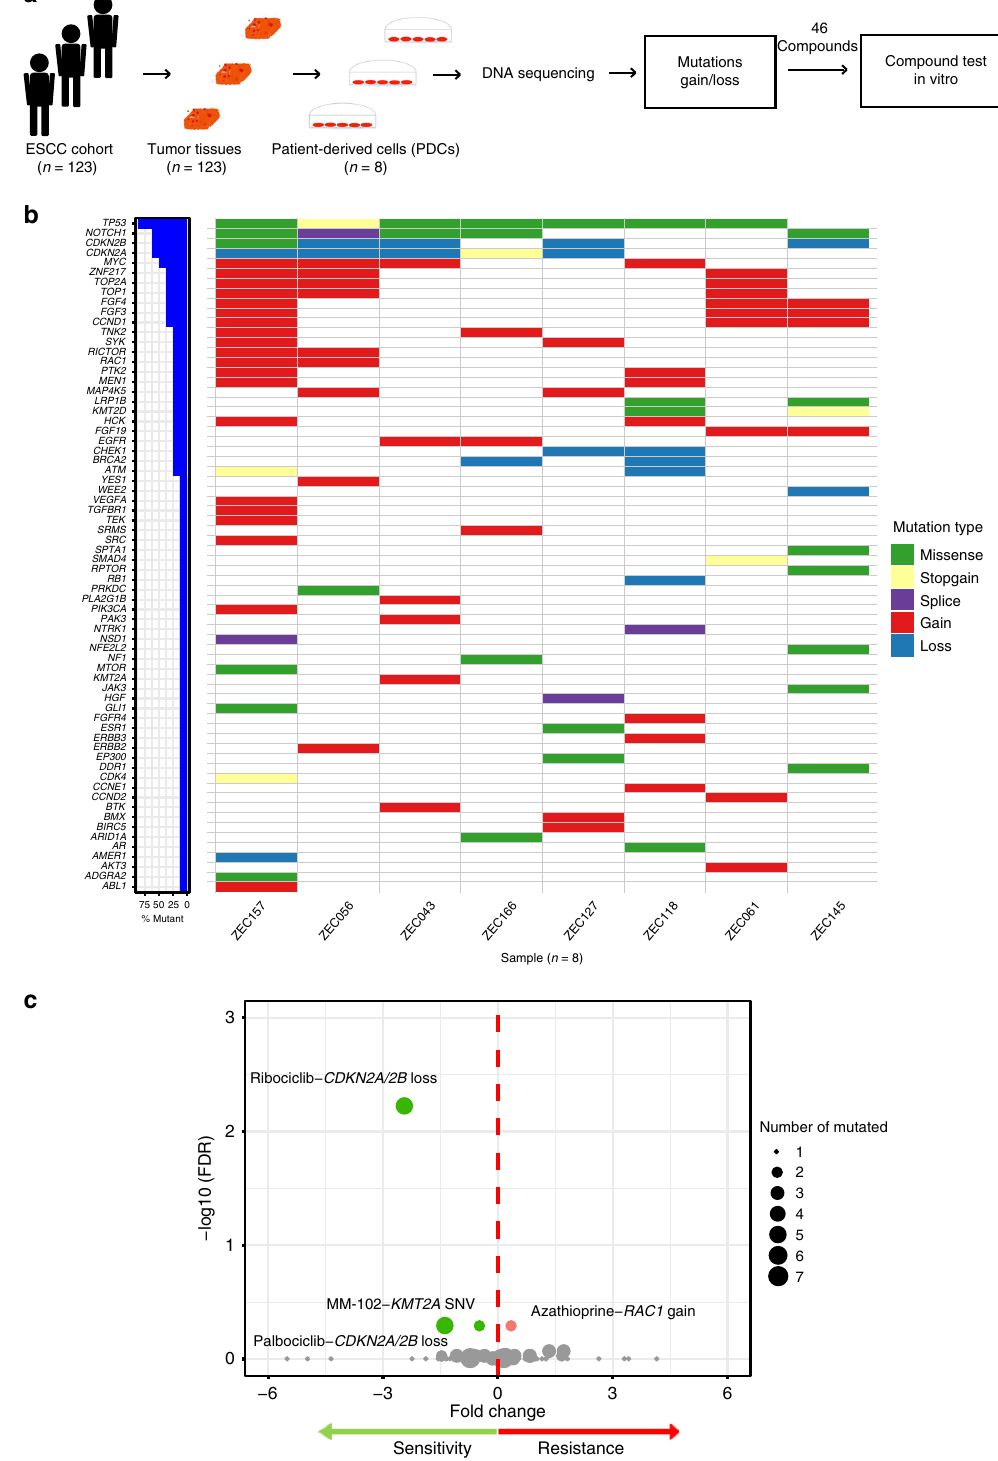
Fig. 2 Exploration of the potential biomarkers of drug sensitivity in ESCC. a A schematic diagram exploring potential biomarkers of drug sensitivity in esophageal squamous cell carcinoma. Eight ESCC patient-derived cells (PDCs) were established from an independent cohort of 123 ESCC patients. DNA sequencing was used to detect the mutations and gain/loss in ESCC PDCs. We used the ESCC PDCs for integrated targeted deep sequencing and drug sensitivity evaluation systems to explore potential biomarkers of drug sensitivity. b The mutational landscape was studied in eight ESCC PDCs. c Each circle represents a single drug – gene interaction, and the size is proportional to the number of mutant cell lines screened (range 1 – 7). An unpaired t test was performed for each drug – gene mutation associations. The top four drug – gene mutation associations sorted by FDR were colored by green (sensitive) and red